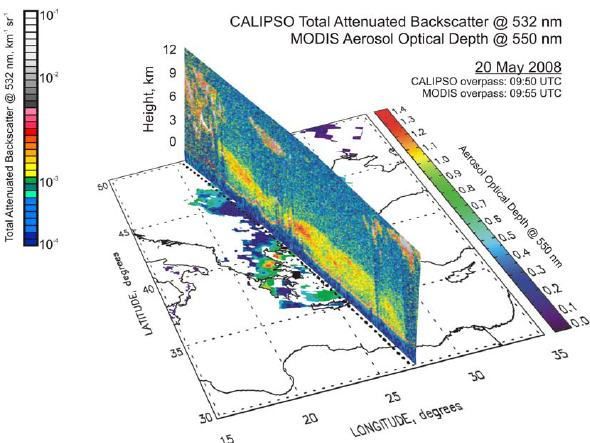
Fig. 3. Three-dimensional representation of dust evolution over Greece for 20 May 2008. Spatial distribution of AOD obtained at 550nm by the MODIS sensor and CALIPSO cross section of the attenuated backscatter coefficient at 532nm.